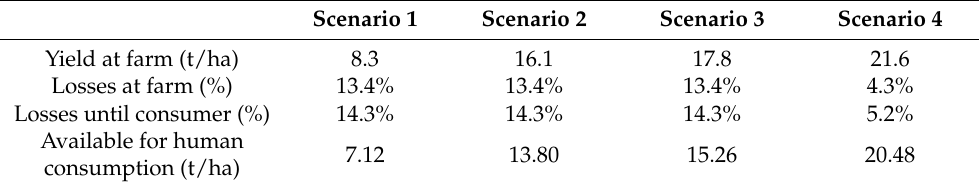
Table 12. Results on Yield, Losses and Food Security. Losses are Calculated in the New Way, as Introduced